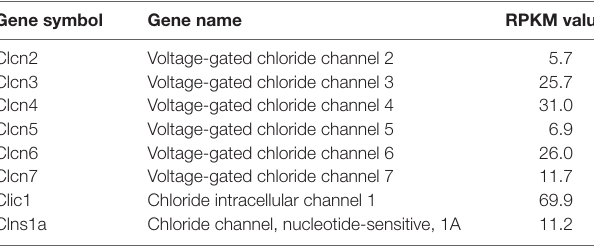
TABLE 2 | List of chloride channels detected by RNA sequencing from wild-type mouse dorsal root ganglia (DRG)